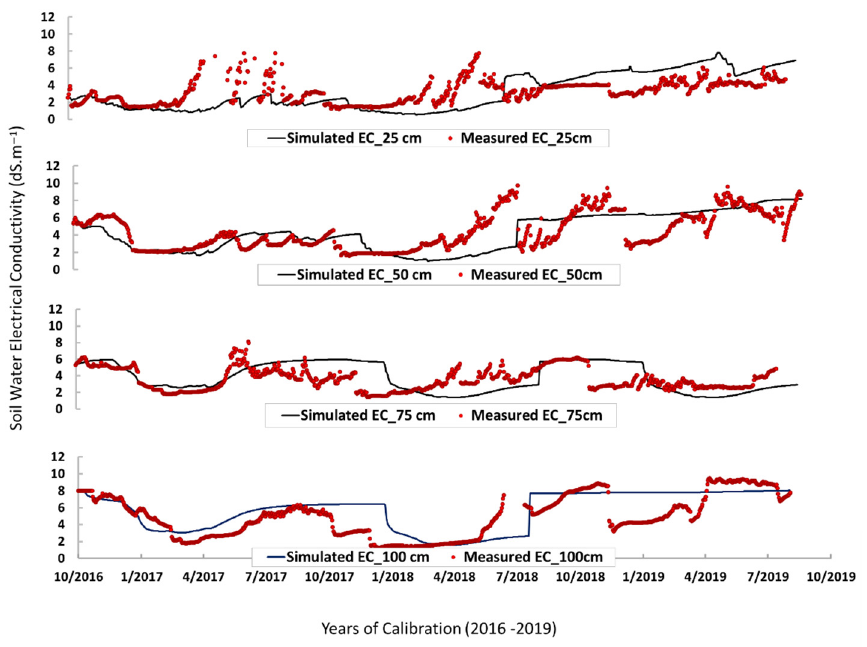
Figure 8. Measured (dots) and simulated (lines) salinities at four observation depths of 25, 50, 75, and 100 cm at the ASL site.